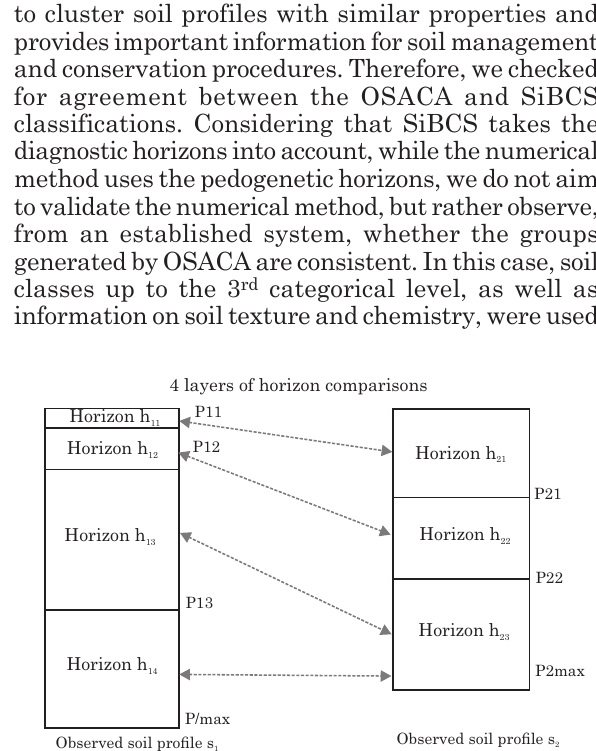
Figure 1. Illustration indicating the profile comparison method. Source: Carré & Jacobson